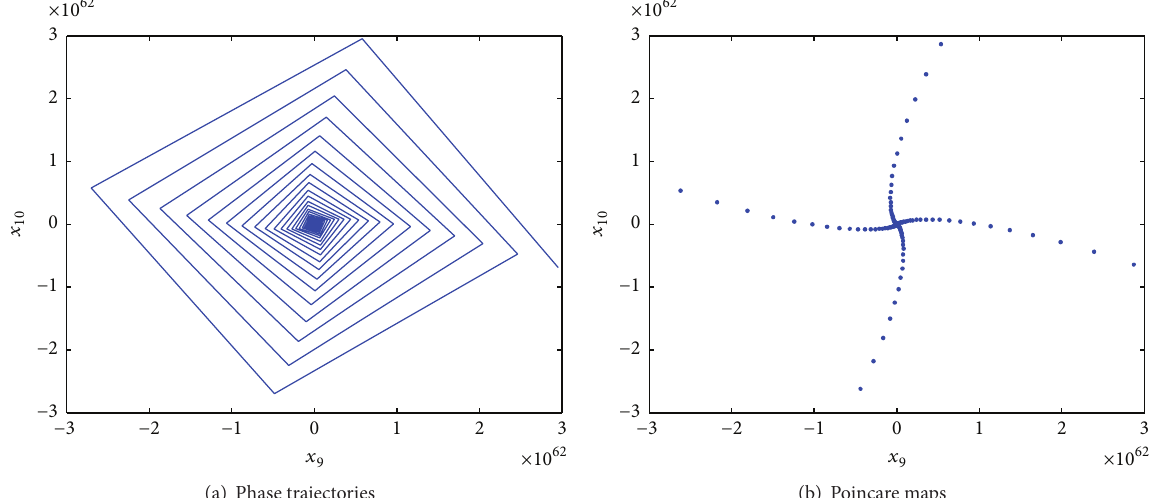
Figure 9: 𝜔 = 262 without random